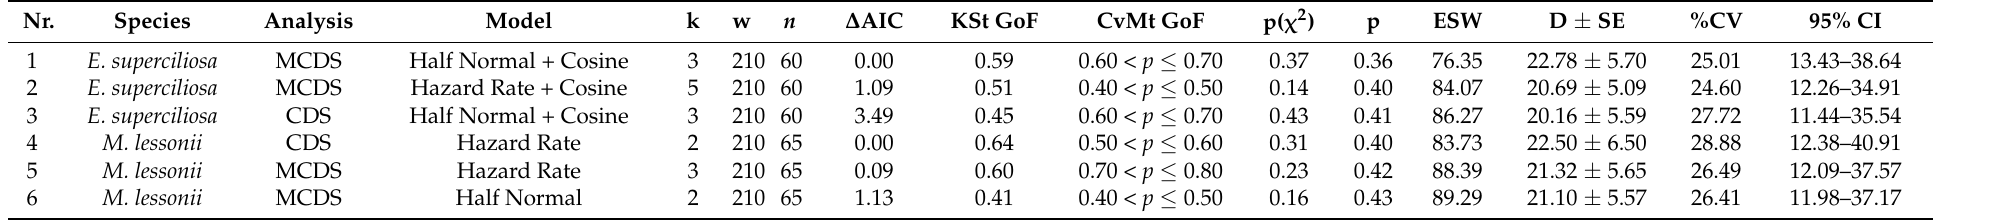
Table 1. Summary of the results of some of the models performed for Eumomota superciliosa and Momotus lessonii . Analyses number (no.) 1 and 5 were used for E. superciliosa and M. lessonii ,